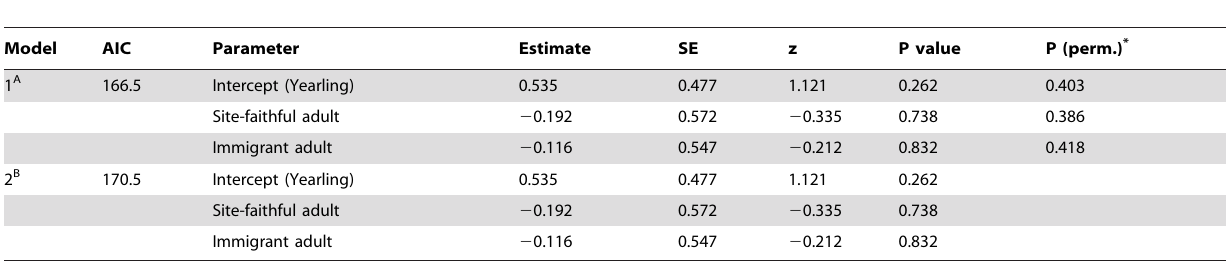
Table 1. The best generalized linear mixed-effects models